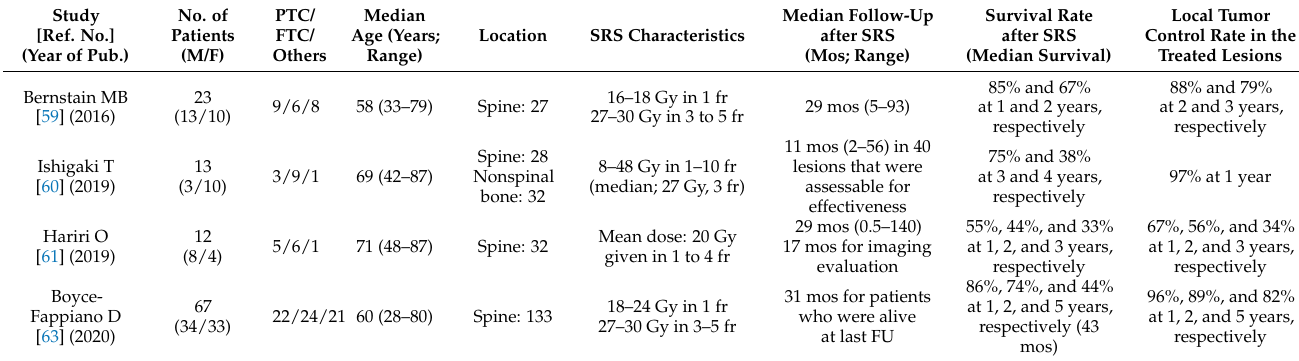
Table 2. Four studies that included detailed outcomes of SRS for BM from thyroid